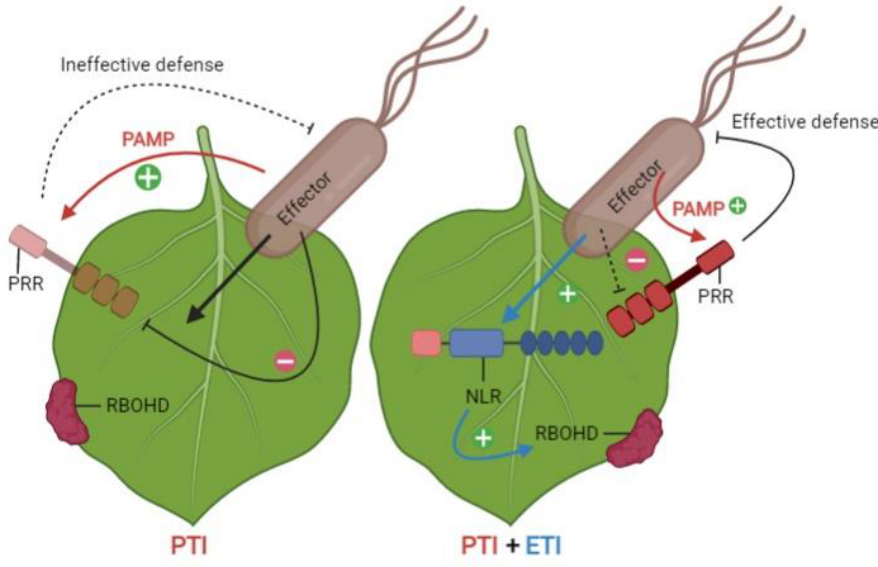
Figure 1. A two-tiered immune system consisting of pattern-triggered immunity (PTI) and effector- triggered immunity (ETI) to cope with pathogen attack. PAMP: Pathogen associated molecular pat- terns, PRR: Pattern recognition receptors, NLR: Nucleotide-binding site-leucine-rich repeat, RBOHD: NADPH oxidases belong to the respiratory burst oxidase homolog.